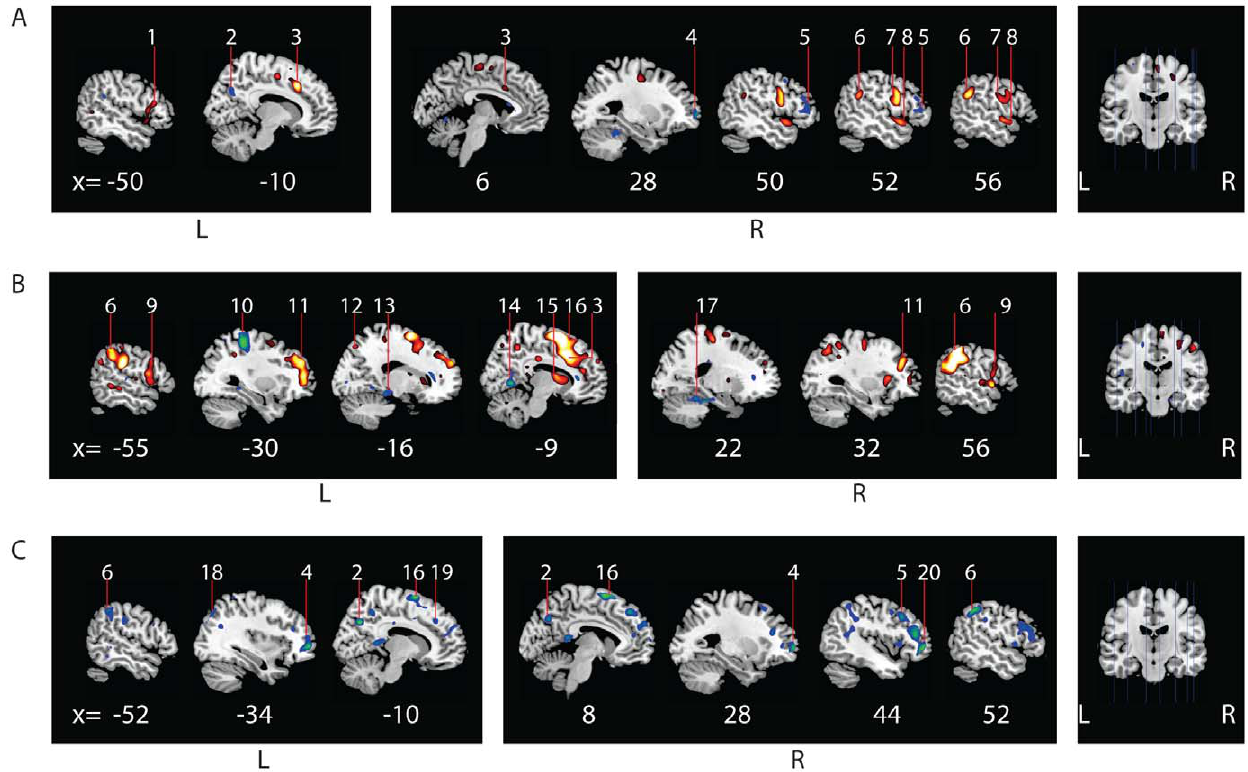
Figure 1. Cerebral activation patterns during movement execution in the affected hand for patients versus normal controls and patients versus feigners. Flipped data for movement execution in the affected side is shown for (A) patients versus normal controls, (B)feigners versus normal controls and (C) feigners versus patients. Figures were created with MRIcron, template Ch2better.nii.gz., without restriction of number of voxels. X-coordinates (in mm) for each saggital section are listed below. Numbers indicate clusters that were significant at cluster-level (P , 0.05, whole-brain corrected at cluster level; k . 200) and are also listed in the Tables. Note that this Figure also displays activity (not numbered) significant at an uncorrected threshold, to preserve explorative qualities of the study. A: Increased activation (red, t=3.16 to yellow, t=7) and decreased activation (blue t=3.16 to green, t=6.0) in patients versus normal controls. B: Increased activation (red, t=3.16 to yellow, t=8) and decreased activation (blue t=3.16 to green, t=6.0) in feigners versus normal controls. C: Decreased activation in patients vs feigners (blue t=3.16 to green, t=7.0). 1=inferior frontal gyrus, 2=precuneus, 3=medial cingulate cortex, 4=frontal pole, 5=ventral lateral prefrontal cortex, 6=supramarginal gyrus, 7=premotor cortex, 8=superior temporal cortex, 9=superior frontal operculum, 10=primary somatosensory cortex, 11=dorso lateral prefrontal cortex, 12=somatosensory association cortex, 13=parahippocampal gyrus, 14=primary/secondairy visual cortex, 15=nucleus caudatus, 16=SMA (in B extending into cingulate cortex), 17=cerebellum, 18=superior parietal cortex, 19=frontal eye fields, 20=orbitofrontal cortex. L=left, R=right.